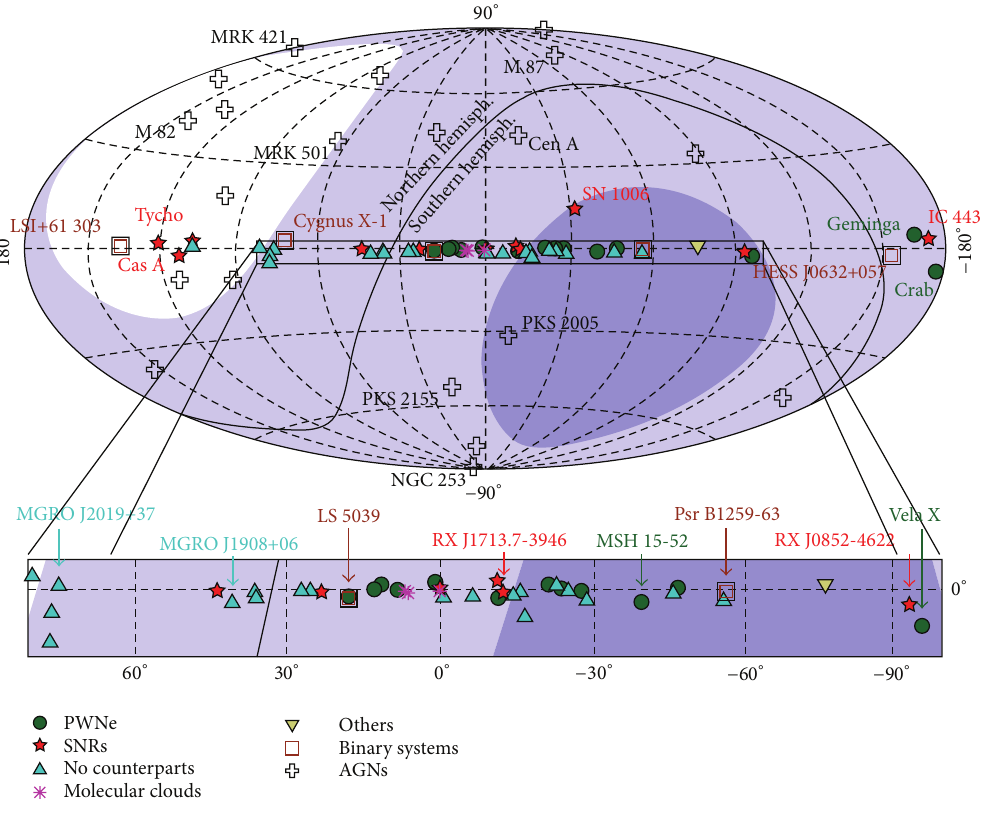
Figure 9: Field of view of IceCube (i.e., the Northern hemisphere) and of a Mediterranean-based neutrino telescope in Galactic coordinates. 2𝜋 downward sensitivity is assumed. Shades of blue which indicate the fraction of time sources are visible for the Northern telescope (light blue: > 25% of the time; dark blue: > 75% of the time). Also indicated are sources of high-energy gamma rays, that is, candidates for neutrino emission. Figure courtesy of A. Kappes